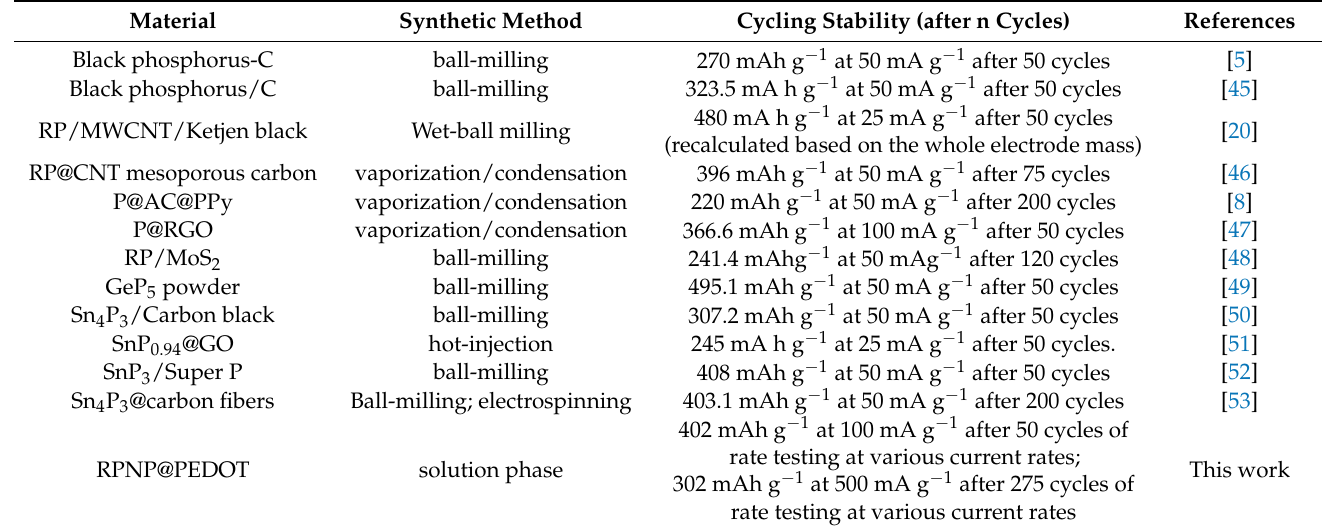
Figure 6. KIB performance comparisons of various phosphorus-based anodes. The specific capacity figures are reliable data after cycling at least 40 cycles. Table 1. Comparison of the potassium storage performance of various phosphorous/carbon-based hybrids.